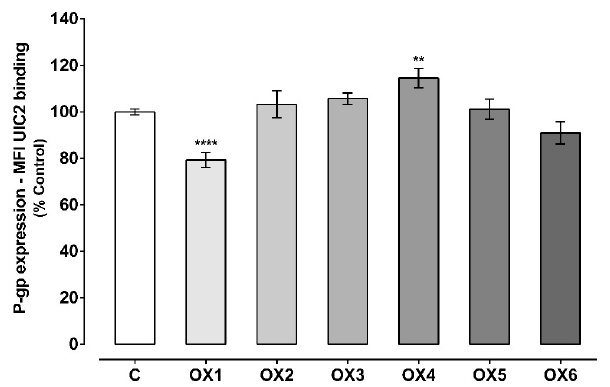
Figure 3. P-glycoprotein (P-gp) expression levels in Caco-2 cells exposed to the six tested oxygenated xanthones (OX 1–6, 20.0 µ M) for 24 h. Results are presented as mean ± SEM from five independent experiments (performed in duplicate). Statistical comparisons were made using one-way ANOVA, followed by Dunnett’s multiple comparisons test, [** p < 0.01; **** p < 0.0001 vs. control (0 μ M)].